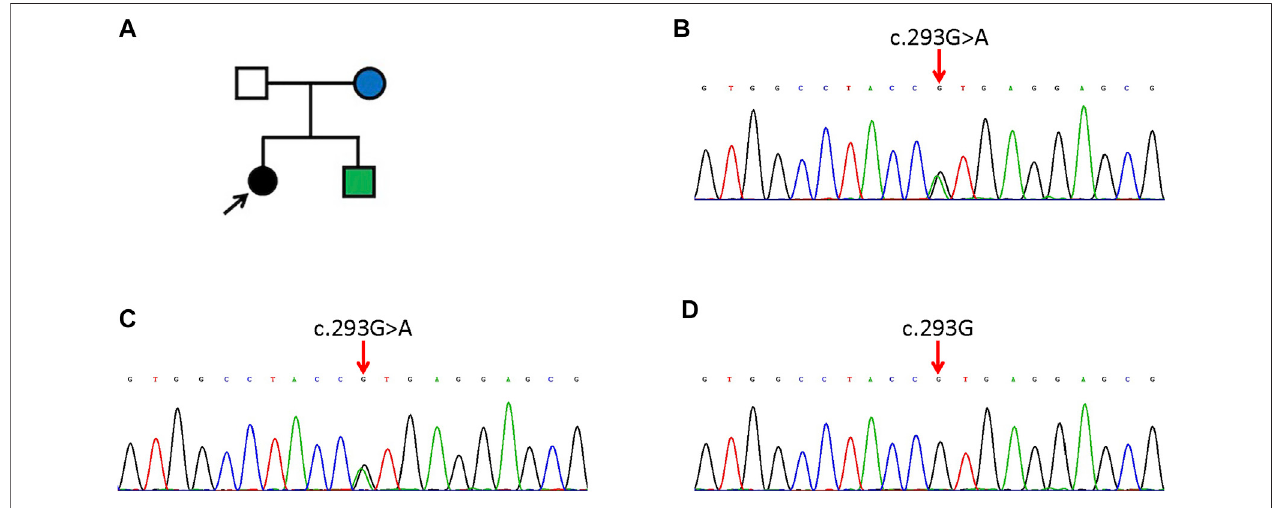
FIGURE2| Thepedigreeofthefamily (A) andWESresultsoftheproband (B) ,hermother (C) andherfather (D) . (A) Thearrowindicatestheproband.Blackmeans EKV. The green one has NSHL and the blue one has ichthyosis. (B,C) The proband and her mother have aheterogenous missense mutation of c. 293G > Ain GJB3 . (D) The proband ’ s father has no mutation (c. 293G) in GJB3